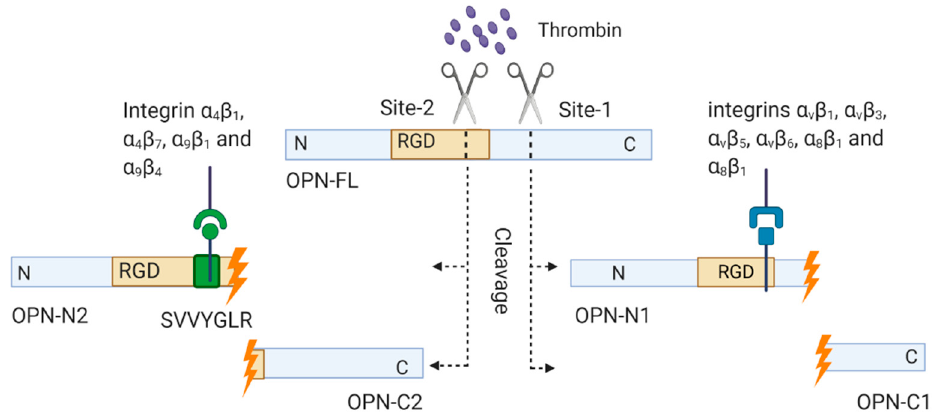
Figure 3. Generation of OPN fragments by thrombin cleavage. OPN can be post translationally modified by thrombin cleavage. Two conserved thrombin cleavage sites have been identified in human OPN. The major site, Site-1 cleavage, produces an N-terminal fragment containing the RGD domain OPN-N1, and a C-terminal fragment OPN-C1. The Site-2 cleavage exposes a cryptic site, the SVVYGLR domain located within the RGD domain. The Site-2 cleavage produces N-terminal fragment, OPN-N2 containing the SVVYGLR domain and C-terminal fragment, OPN-C2. The figure was created in